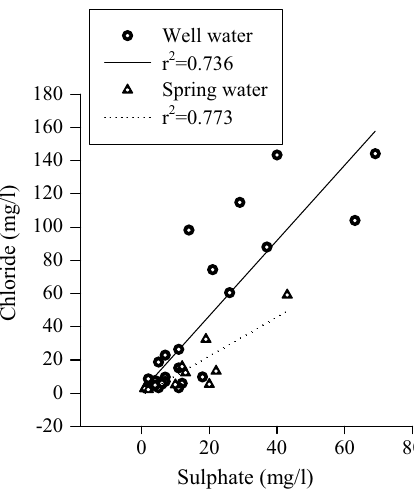
Fig. 7 Phosphate variations with well